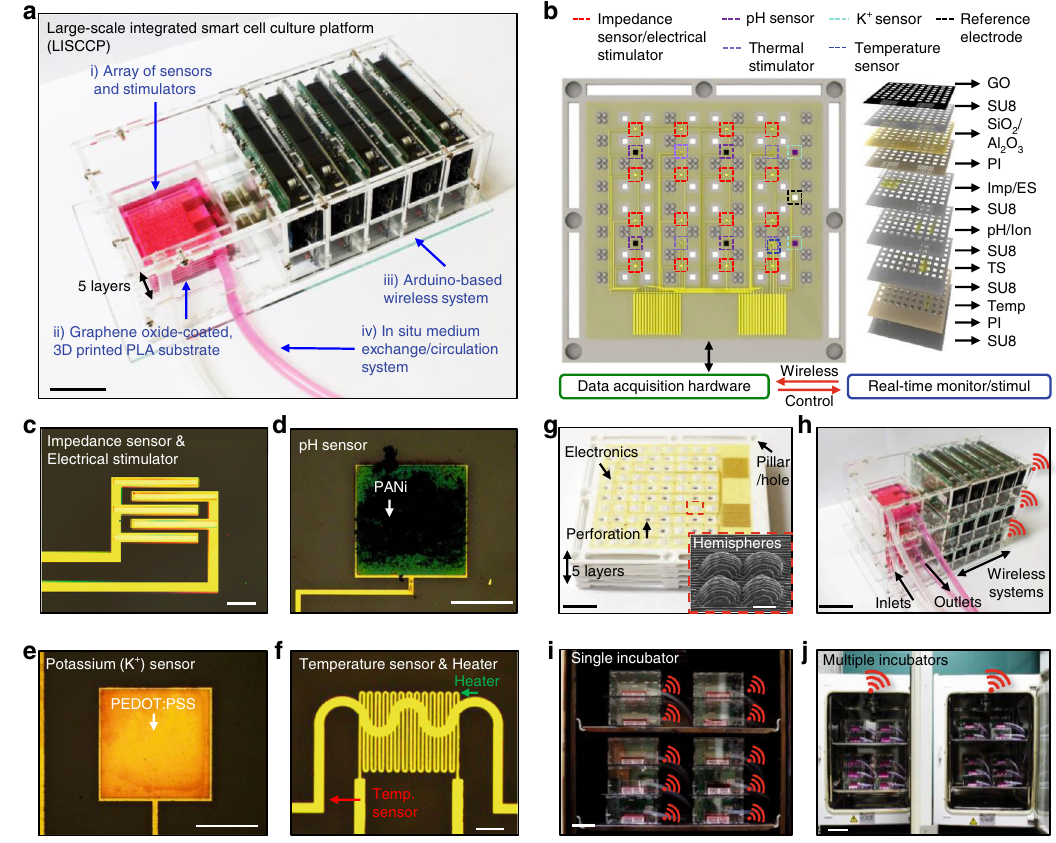
Fig. 1 Large-scale, integrated, and smart cell culture platform. a Photograph showing LISCCP. Scale bar: 2 cm. b Schematic illustration of the ultrathin sensors and stimulators transfer-printed to the 3D engineered substrate to be integrated with the wireless control system (left) and the exploded view of the ultrathin device layers (right). c – f Optical microscopic image of the impedance sensor/electrical stimulator ( c ), pH sensor ( d ), K + sensor ( e ), and temperature sensor and heater ( f ). Scale bars for c , f : 200 μ m; for d , e : 500 μ m. g Photograph showing the fi ve-layer stacked 3D-printed engineered PLA substrates that were designed with protruding hemispheres ( D = 1 mm, inset), perforations (1 mm × 1 mm), and stackable pillars and holes and integrated with the ultrathin electronics. Scale bar: 1 cm. Inset shows the SEM image of the protruded hemispheres. Scale bar: 500 μ m. h Photograph of the 3D stack assembly of three LISCCPs. Scale bar: 5 cm. i Photograph of a CO 2 incubator fi lled with multi-stacked LISCCPs (a total of 10) for digital mass cell culture. Scale bar: 5 cm. j Photograph of two CO 2 incubators fi lled with multi-stacked LISCCPs wirelessly integrated with a single laptop. Scale bar: 10